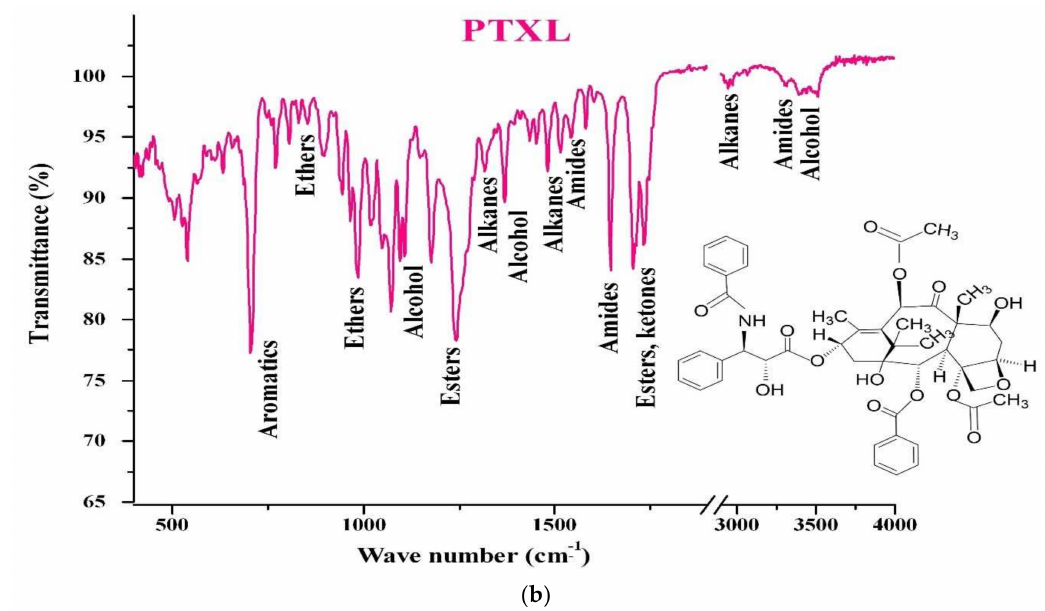
Figure A3. Fourier-transform infrared spectroscopy (FTIR) patterns: ( a ) FT-IR pattern of GEF with labelled peaks corre- sponding to the functional groups present in its chemical structure (break in x -axis: 2100–2800 cm − 1 ); ( b ) FT-IR pattern of PTXL with labelled peaks corresponding to the functional groups present in its chemical structure the drug (break in x -axis: 1900–2900 cm − 1